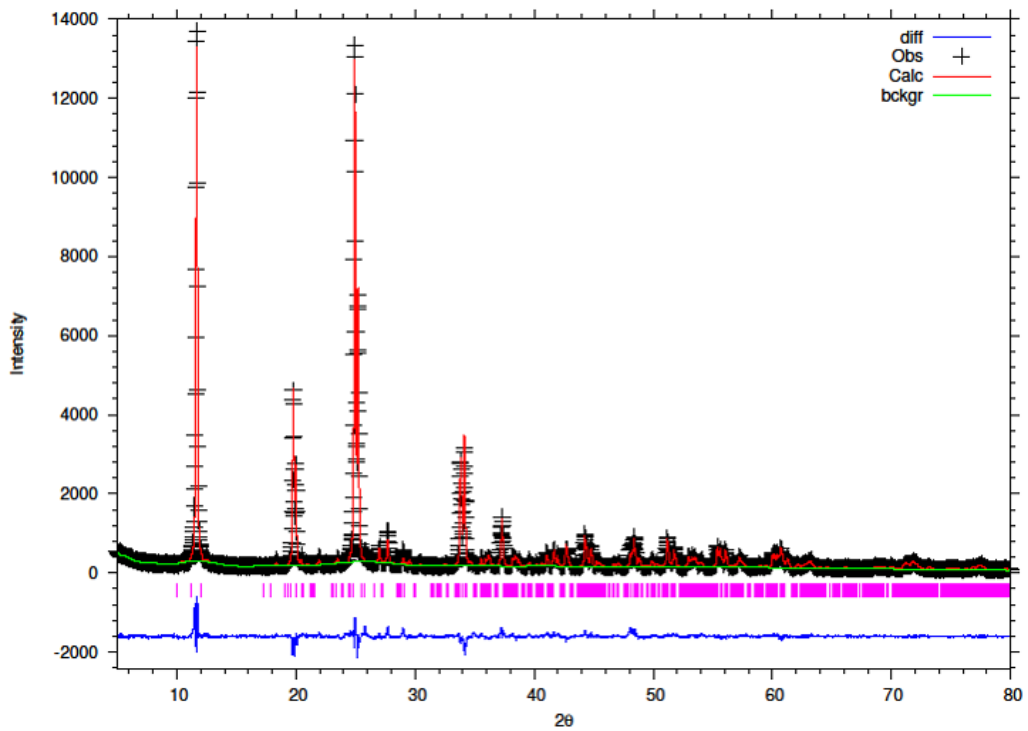
Figure 11. Final observed (cross), calculated (red line) and difference (blue bottom) Rietveld plots for conventionally reflux 10% Y–ZrP.